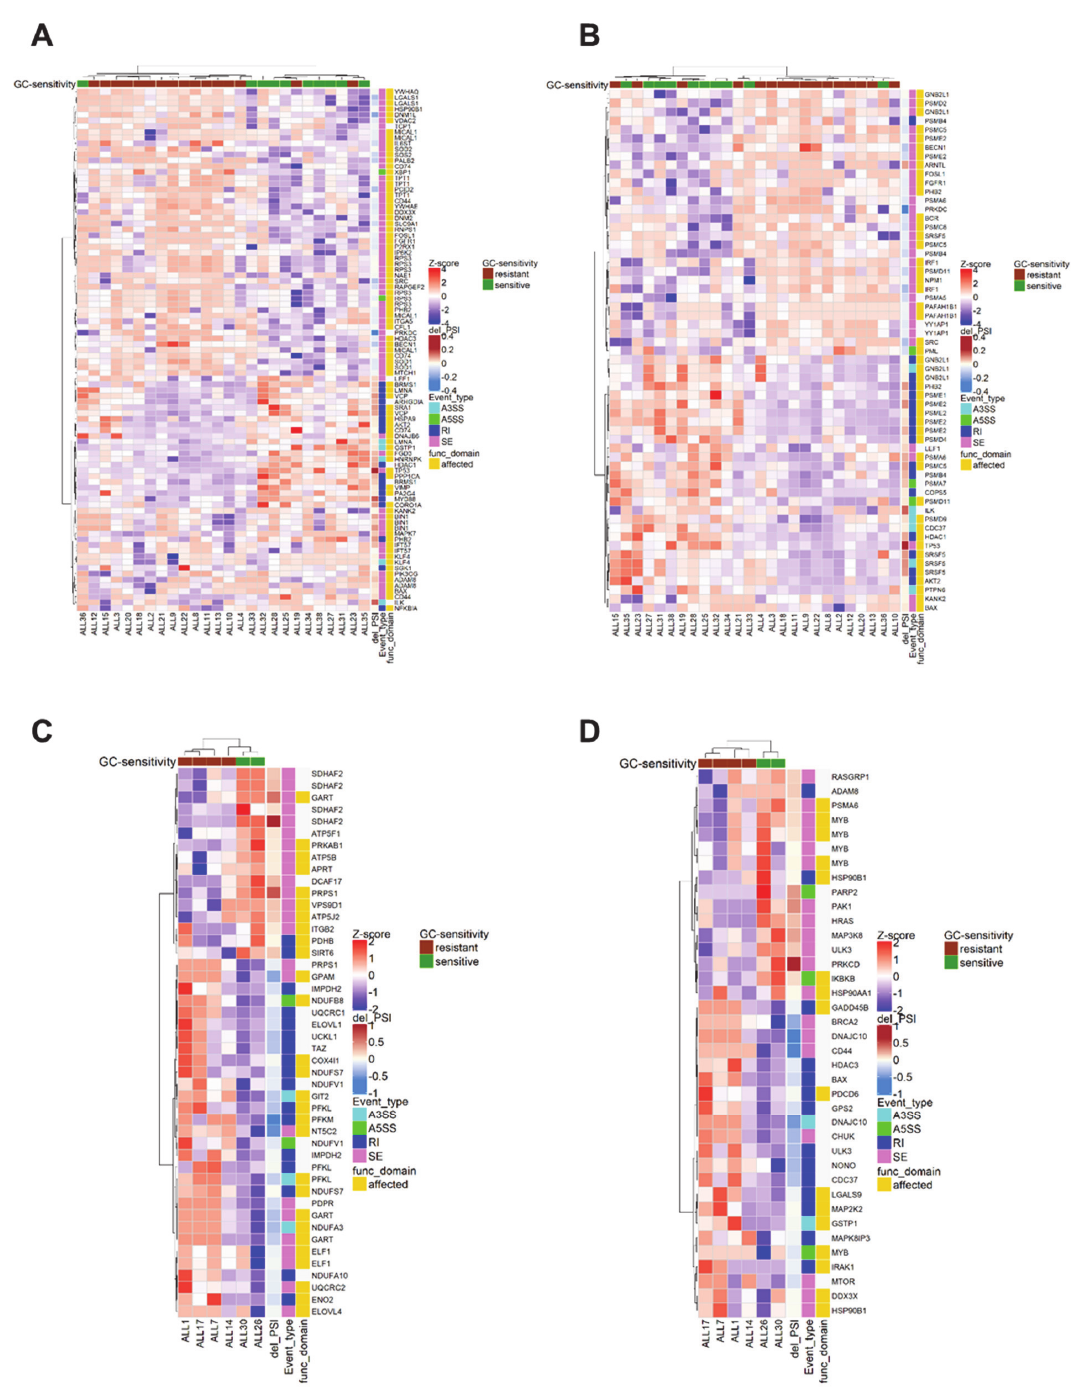
plotted as a heatmap. The colored bar over the heatmap represents the subtype of ALL (yellow—BCP- ALL, blue—T-ALL). ( D ) PCA plot created by using Ψ values for all significant differential splicing events. ( E ) Top 20 major GO terms with the largest numbers of genes in the dataset. GO search was performed in ClueGO (Cytoscape plugin) using all genes affected by significant differential splicing events.